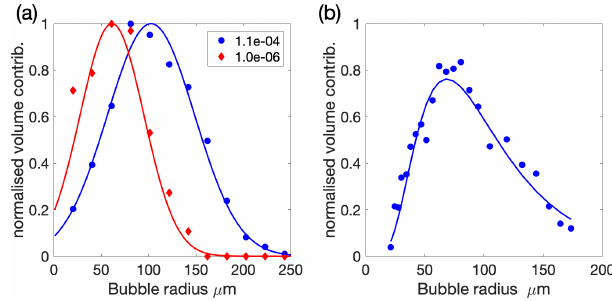
Figure C1. Examples of fitting Gaussian distributions to normalised bubble volume distributions. The dots show the bubble numbers in each size bin and the lines are the fits. Panel (a) shows two exam- ples (labelled by their void fraction) at 2m depth, and (b) shows an example from 4m with a void fraction of 4 . 8 × 10 − 8 and a fitted peak radius of